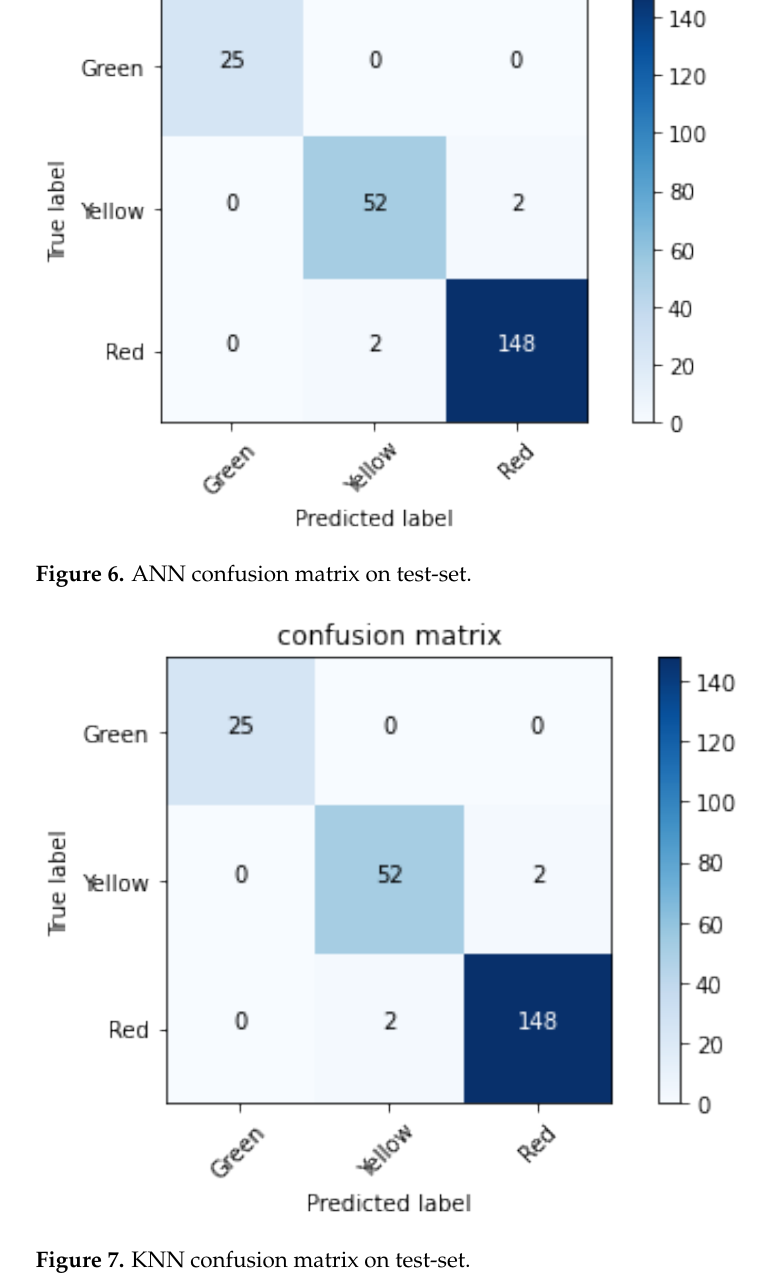
Figure 7. KNN confusion matrix on